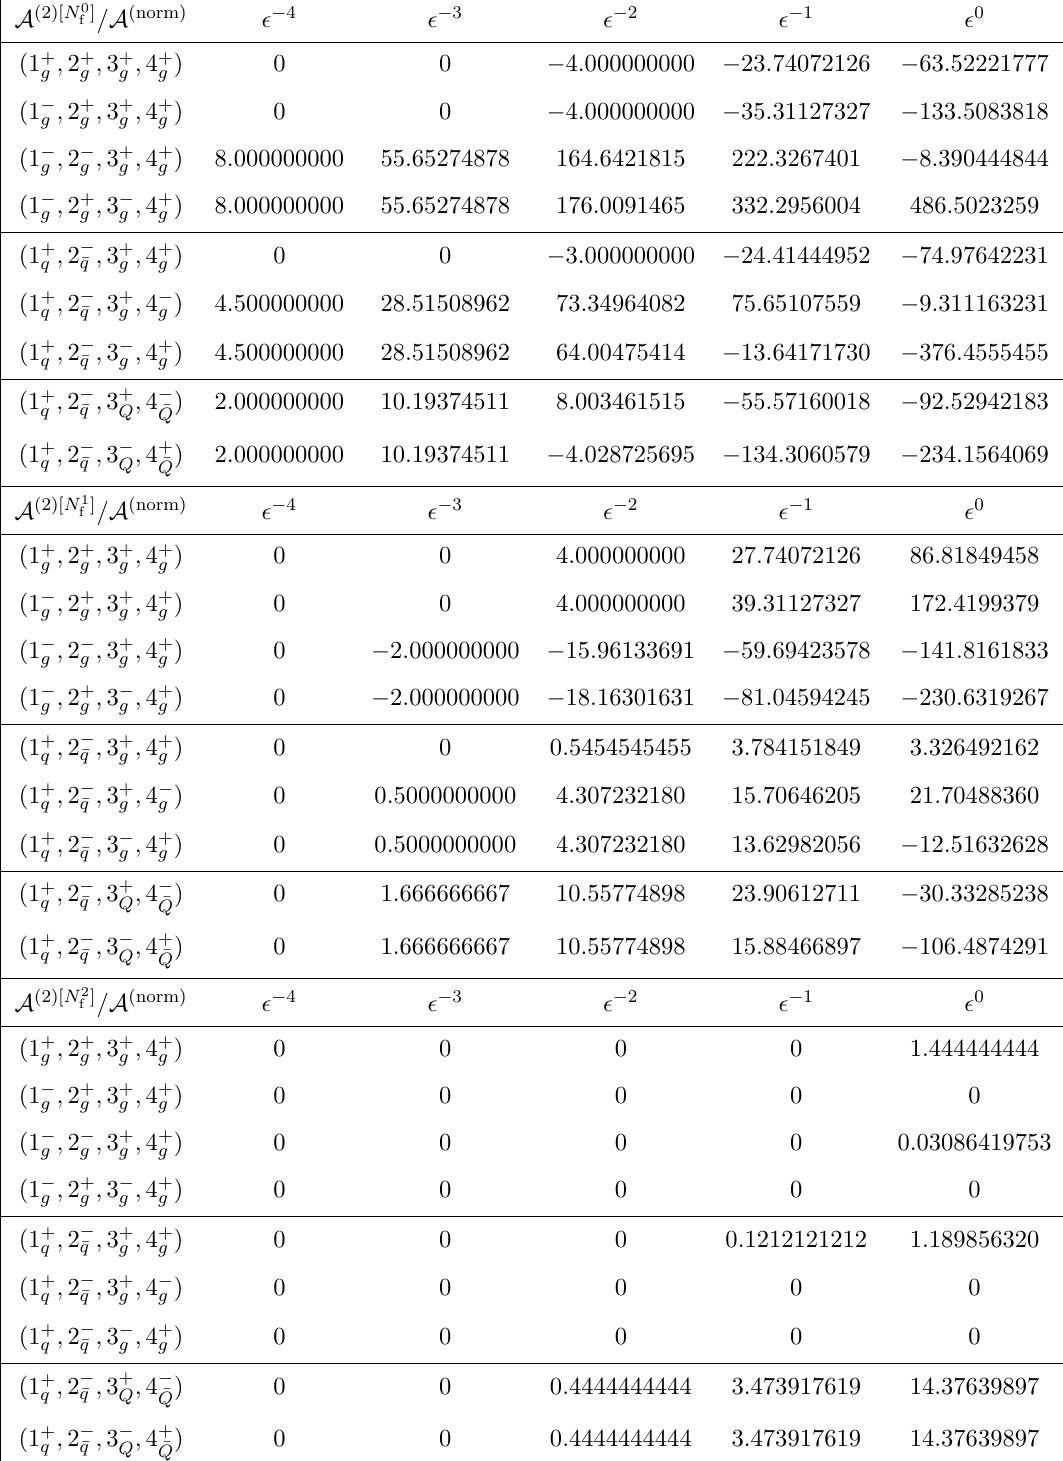
Table 1 . The bare two-loop four-parton helicity amplitudes evaluated at the phase space point in eq. (4.1). We set the normalization factor A (norm) to A (1)[ N 0 f ] ( (cid:15) = 0) for the amplitudes with vanishing trees, and to A (0)